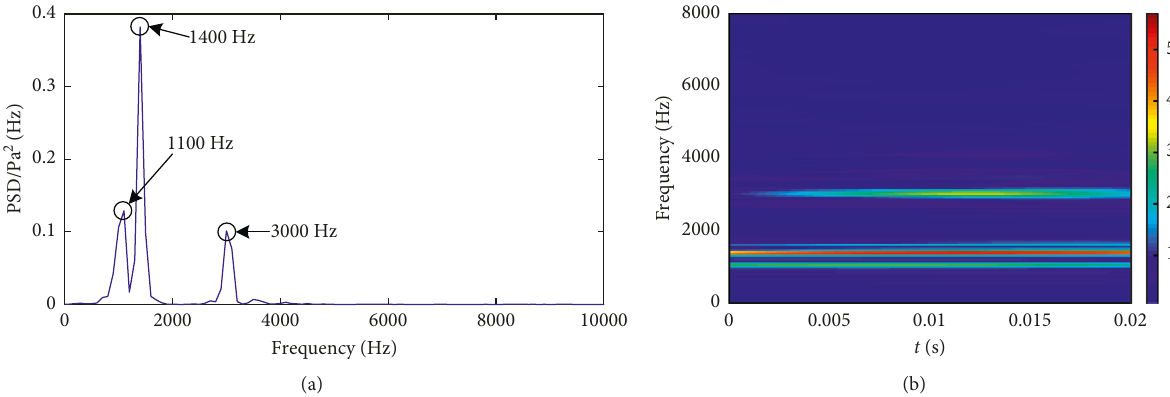
Figure 13: Calculated combustion noise of internal combustion engine at 1500rpm and no-load condition. (a) Spectrum and (b) time- frequency diagram.